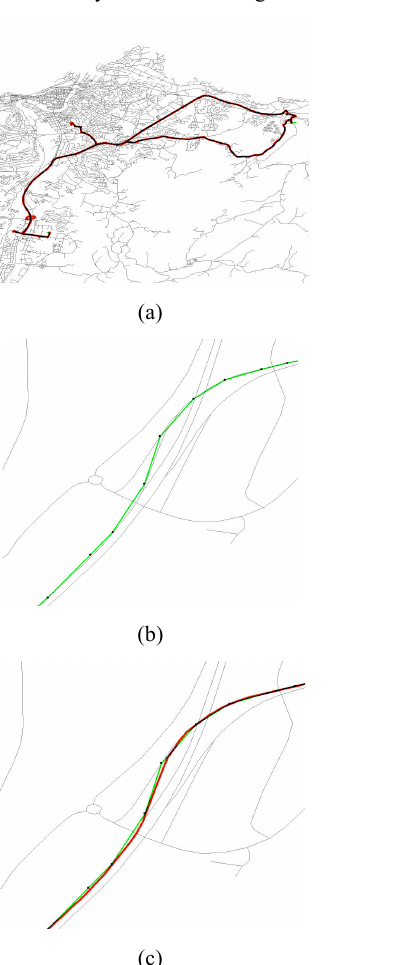
Figure 4 The overall view and a partial enlarged view by tracks2 matching